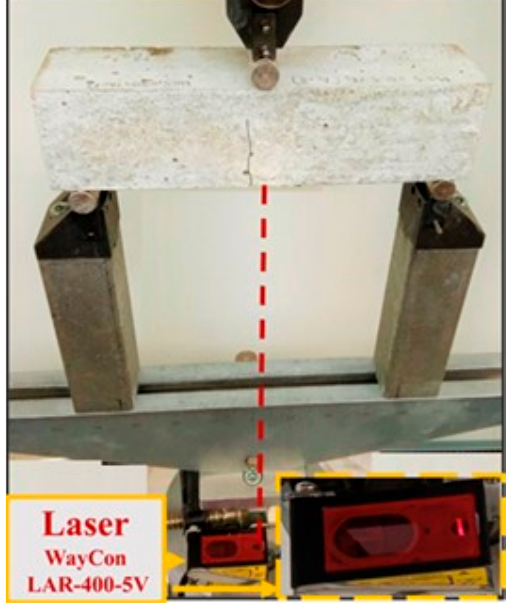
Figure 2. Three-point bending experimental setup with laser measurement.